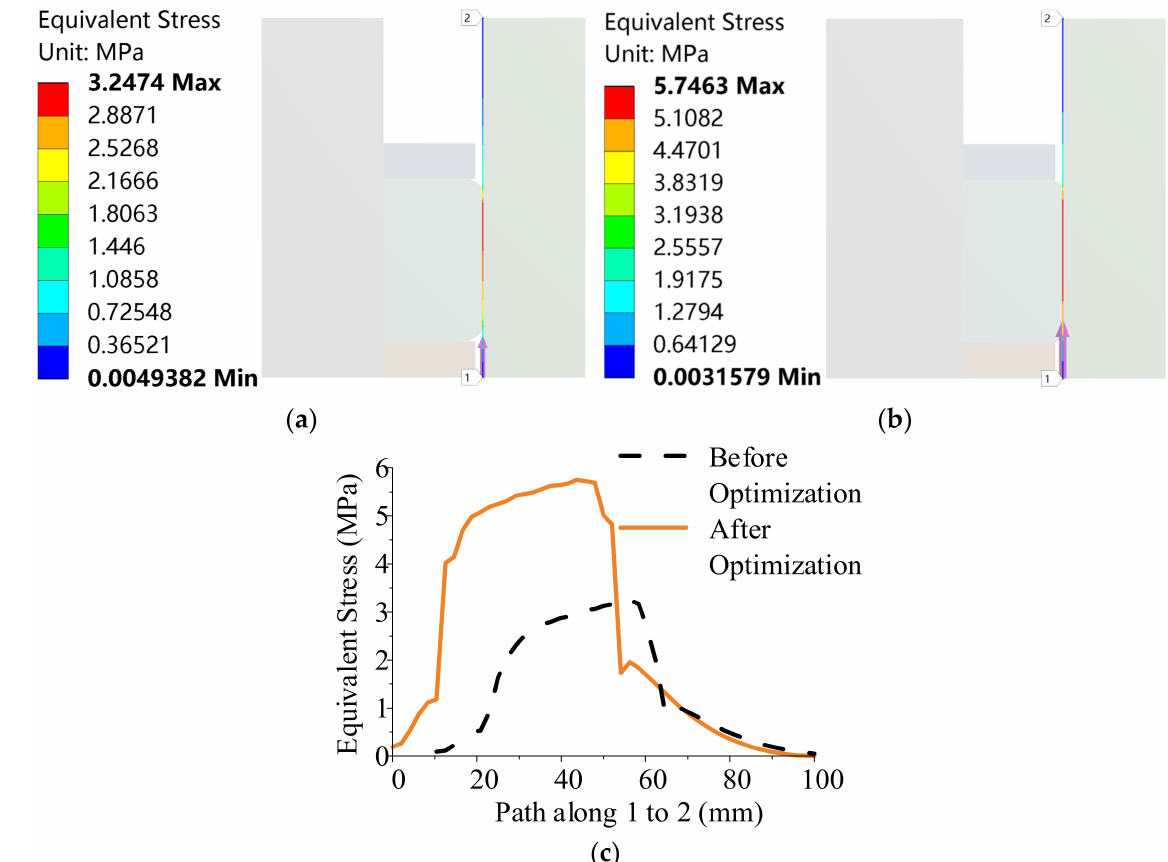
Figure 11. Diagram of equivalent stress comparison along path 1 to 2. ( a ) Inner side equivalent stress of the casing wall before optimization; ( b ) Inner side equivalent stress of the casing wall after optimization; ( c ) Equivalent stress comparison before and after